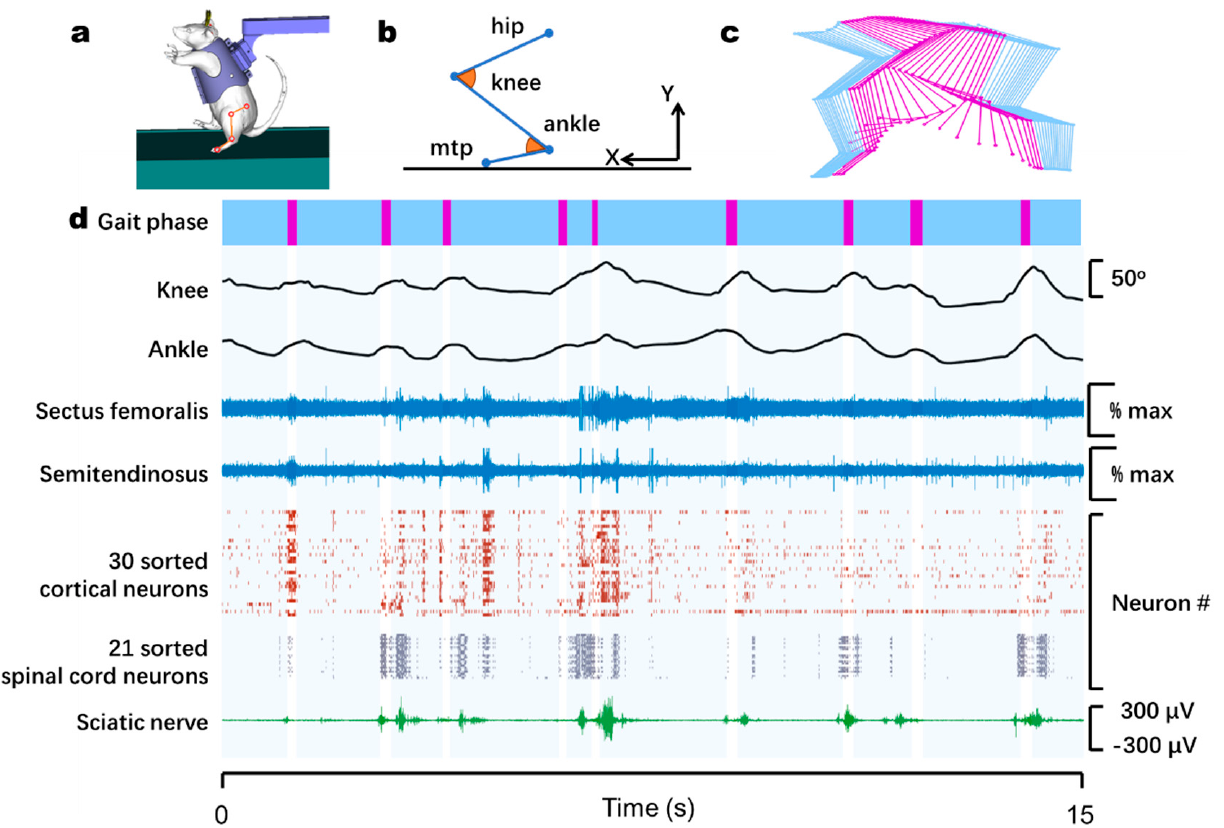
Figure 4. Application of multisite recording for the study of whole motor-related neural pathway and locomotion of bodyweight-supported bipedal walking on a lab-made treadmill. ( a ) An upper-body-fixed rat walking on the treadmill, with an intra-cortical MEA in the M1 leg area, an fMEA in the spinal cord, a wireless transmitter on the sciatic nerve, and EMG recordings from two muscles. The red dots and lines highlight the position of markers magnified in ( b ). The positive X is the stepping direction. The angle of the inner corner of knee and ankle are in orange. ( c ) A skeletal reconstruction of the markers during one cycle of stepping. ( d ) Demonstration of data from one rat. From top: gait phase (purple, swing phase; blue, stance), angle of joints, EMGs of two muscles, raster plot of cortical neurons, spinal cord signals, and continuous potential of sciatic nerve.